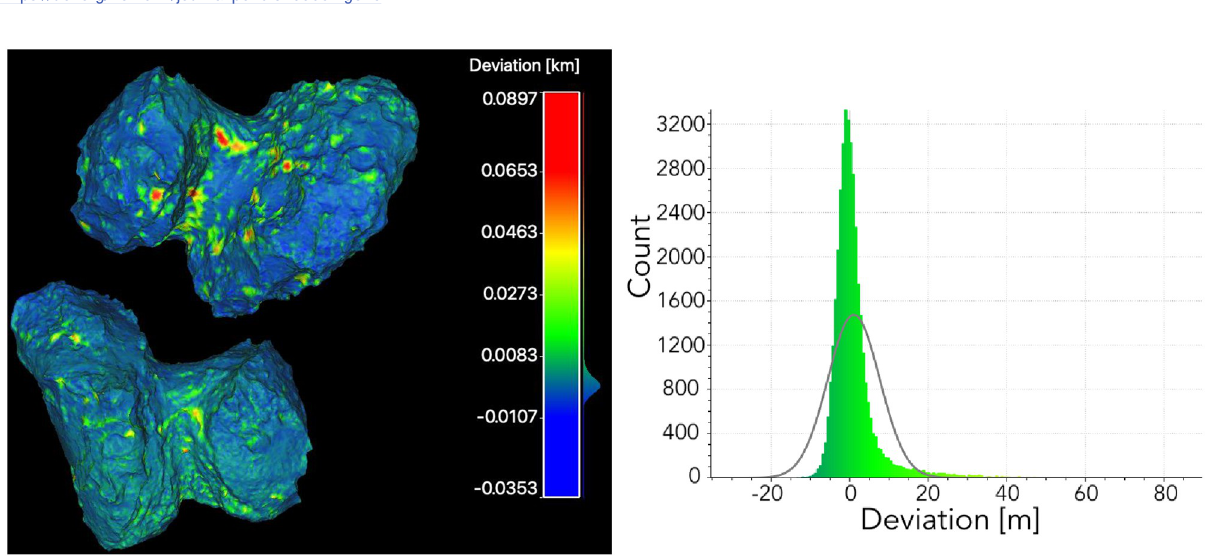
Fig 17. Deviation analysis of the entire reconstructed mesh and input 3-D model for image synthesis. Visualisation of deviation (left); errors and Gaussian distribution (right).